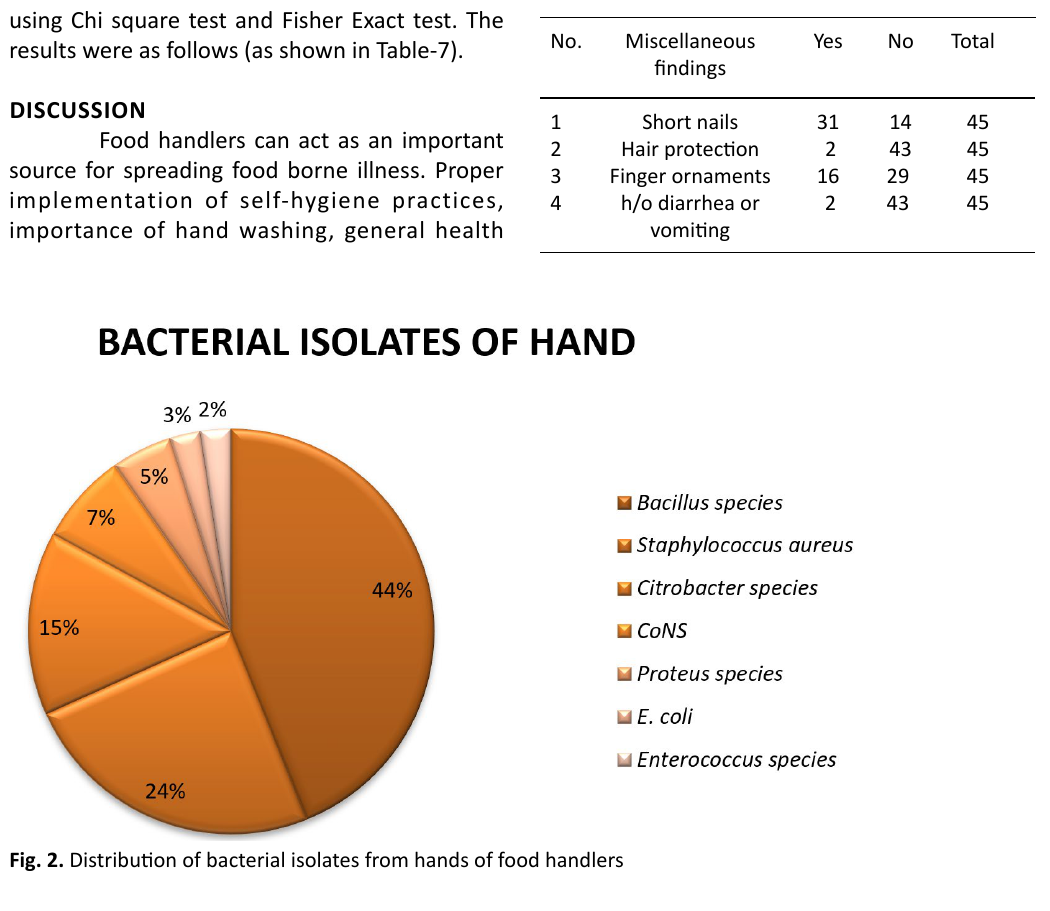
Table 6. Self hygiene practices among food